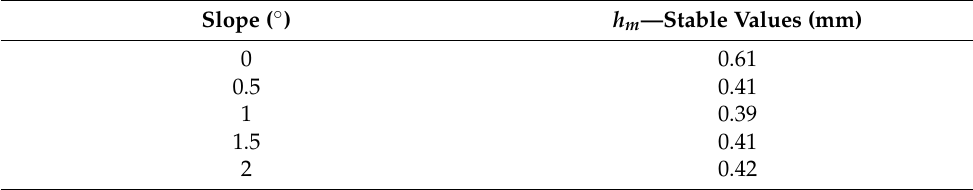
Table 3. h m value under different slopes.